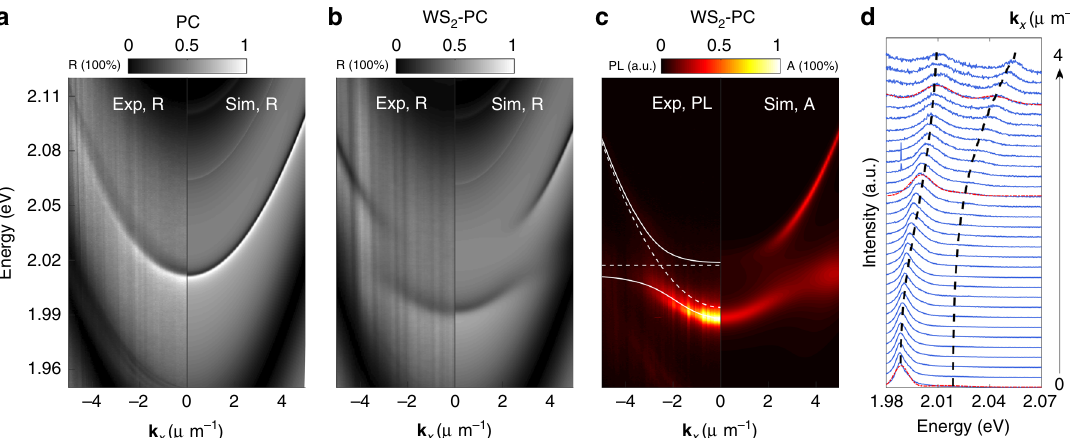
Fig. 4 Room-temperature strong coupling between TE-polarized WS 2 exciton and PC modes measured by angle-resolved re fl ectance and PL. The left/right panels are the measured/simulated results, respectively. a Angle-resolved re fl ectance spectra of the bare PC, showing a sharp, dispersive PC mode. b Angle-resolved re fl ectance spectra of the WS 2 -PC integrated device, showing split, anti-crossing upper and lower polariton modes. c Angle-resolved PL data (left) compared with the simulated absorption spectra of the WS 2 -PC integrated device, showing the same anti-crossing polariton modes as in b . The solid lines are the fi tted polariton dispersion, with a corresponding vacuum Rabi splitting of 22.2 meV. Dashed lines represent the exciton and cavity photon dispersion. d Normalized PL intensity spectra from c for k x = 0 μ m − 1 (bottom) to k x = − 4 μ m − 1 (top). From Gaussian fi ts to the spectra (see Supplementary Figure 5 for examples), we extract the polariton energies at each wavevectors. The black dashed lines mark the fi tted LP and UP positions, corresponding to the white solid lines marked in